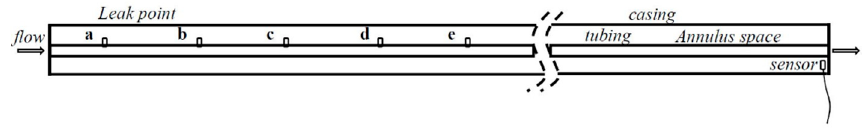
Figure 8. Leak positions in the experiments.